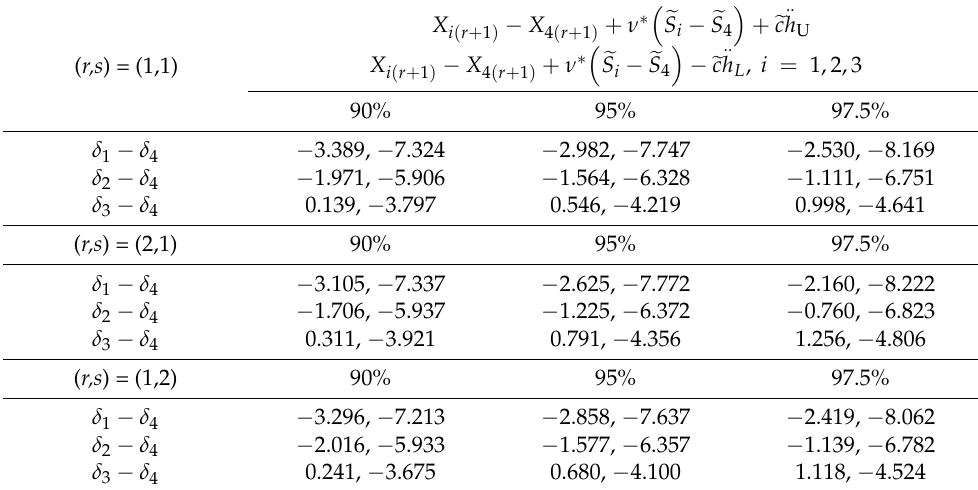
Table 2. The upper and lower confidence bounds for three drugs compared with the control drug (drug 4).